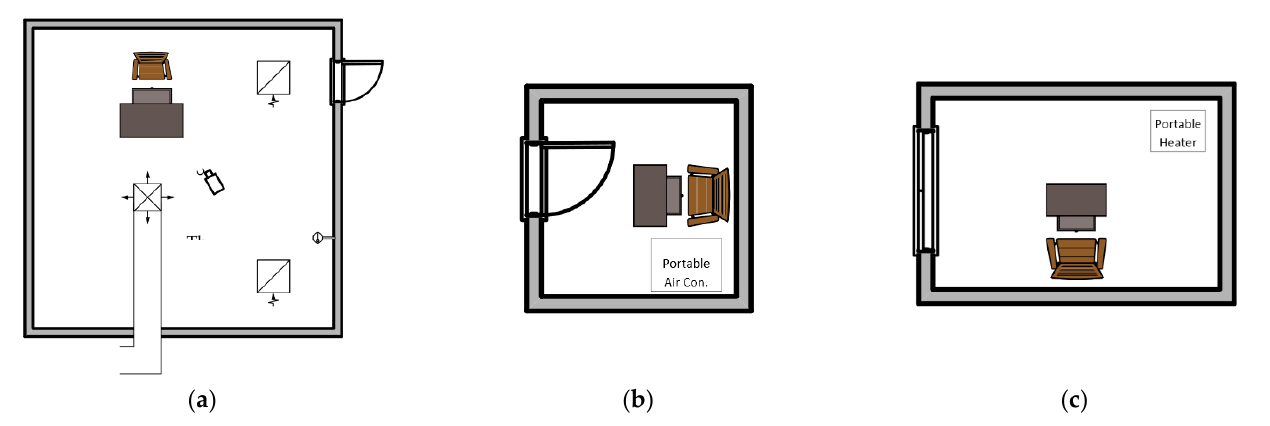
Figure 4. Climate chambers at UC Berkeley, including ( a ) Chamber 1 (Neutral environment at 24 °C with setpoint controller), ( b ) Chamber 2 (cool environment at 18 °C), and ( c ) Chamber 3 (warm environment at 31 °C).